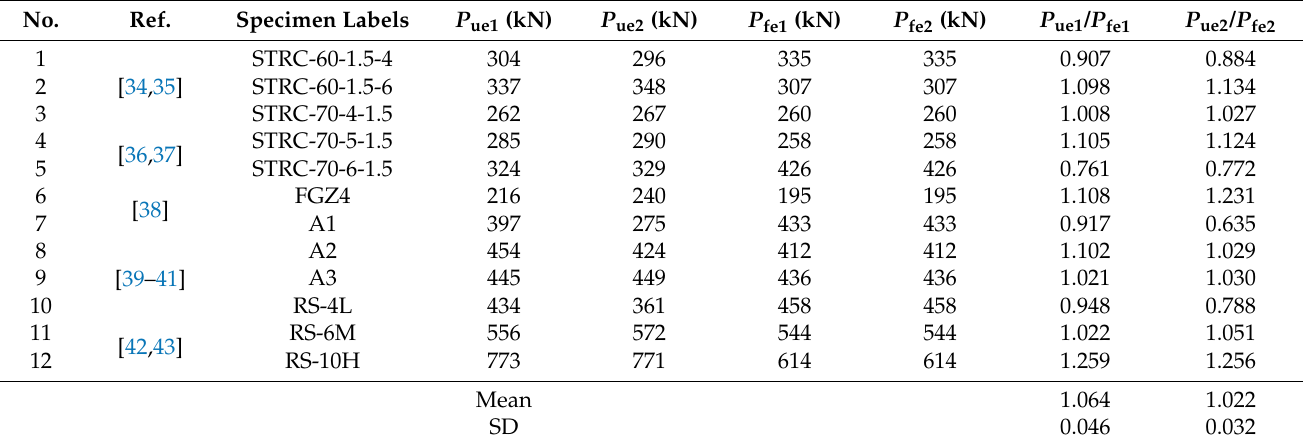
Table 2. Comparison of ultimate horizontal load between specimens and FE model.